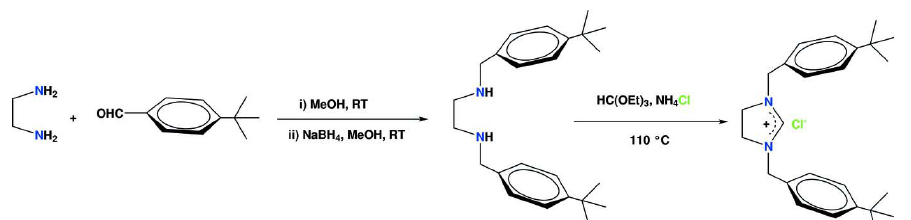
Figure 2 A packing diagram for (I).